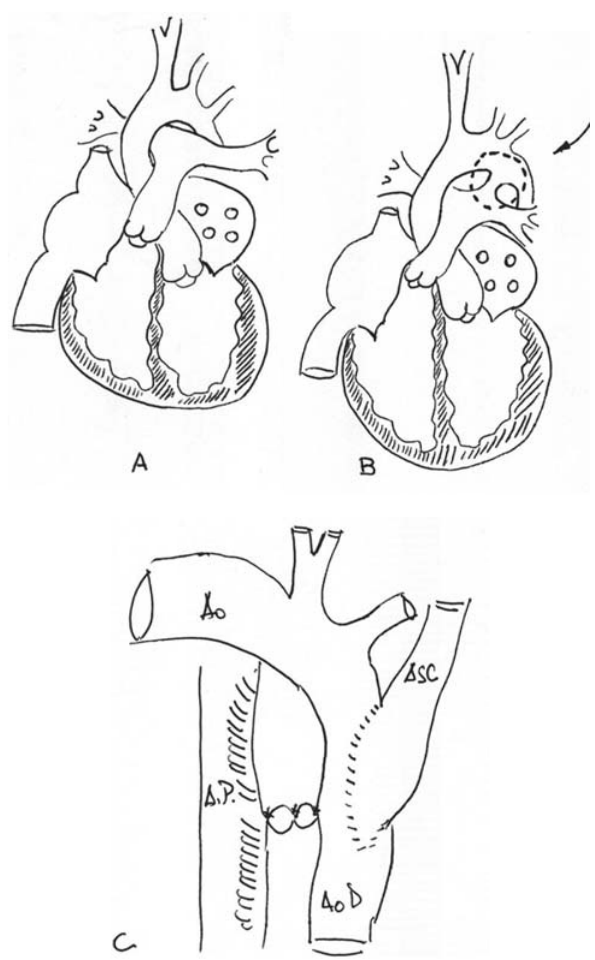
Fig. 1 – Desenhos de Danton Rocha Loures. A) Coração